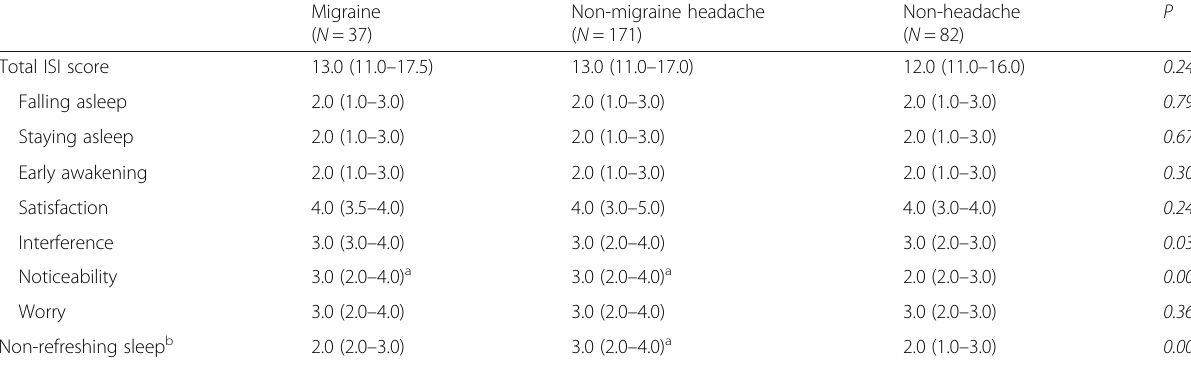
Table 2 Total ISI and its subcomponent scores among participants with insomnia in relation to the headache status